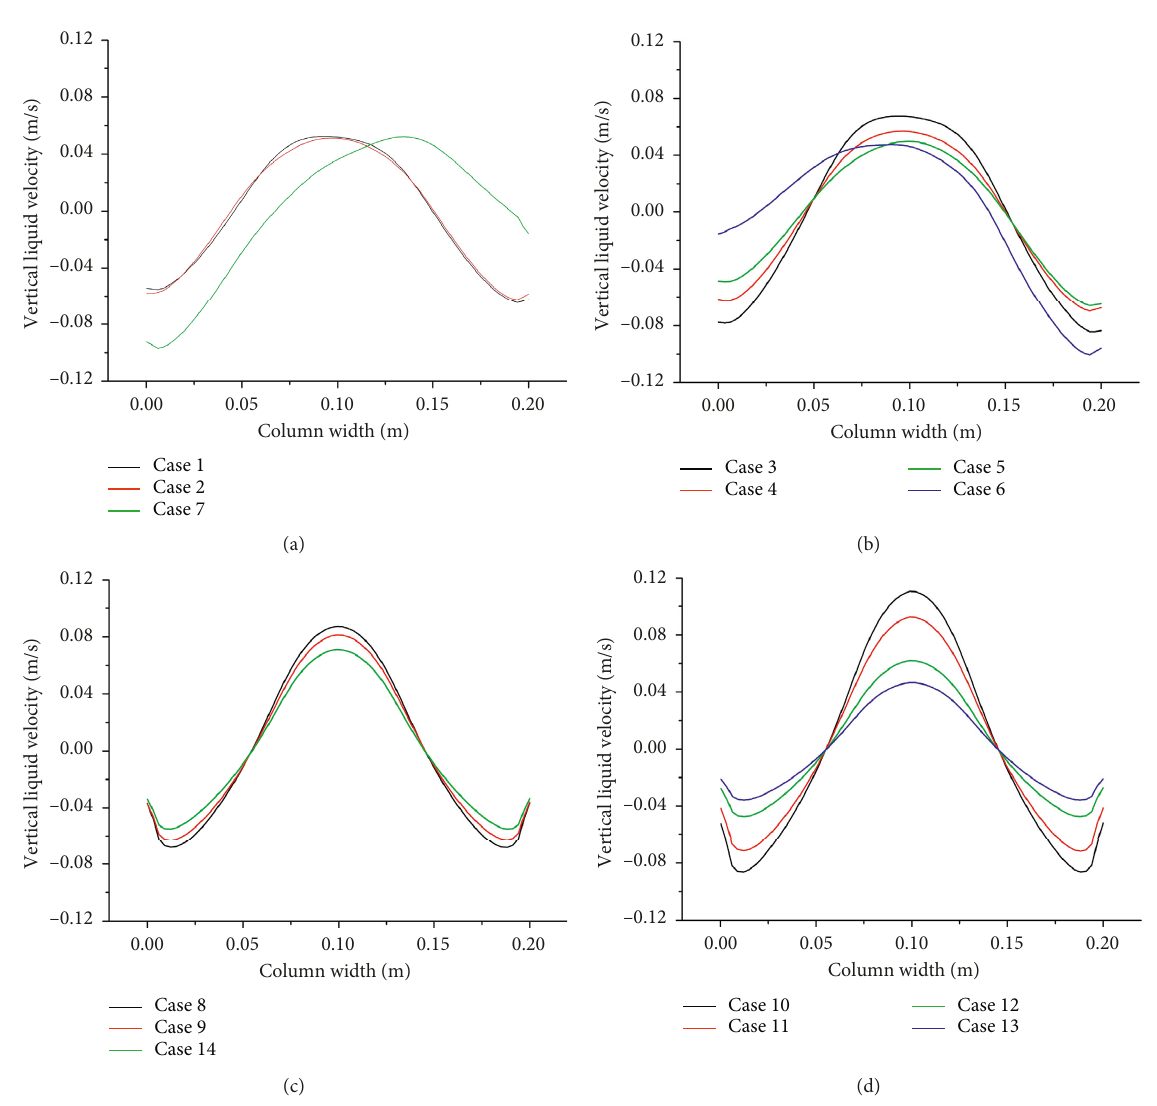
Figure 4: Vertical time-averaged velocity distribution of liquid